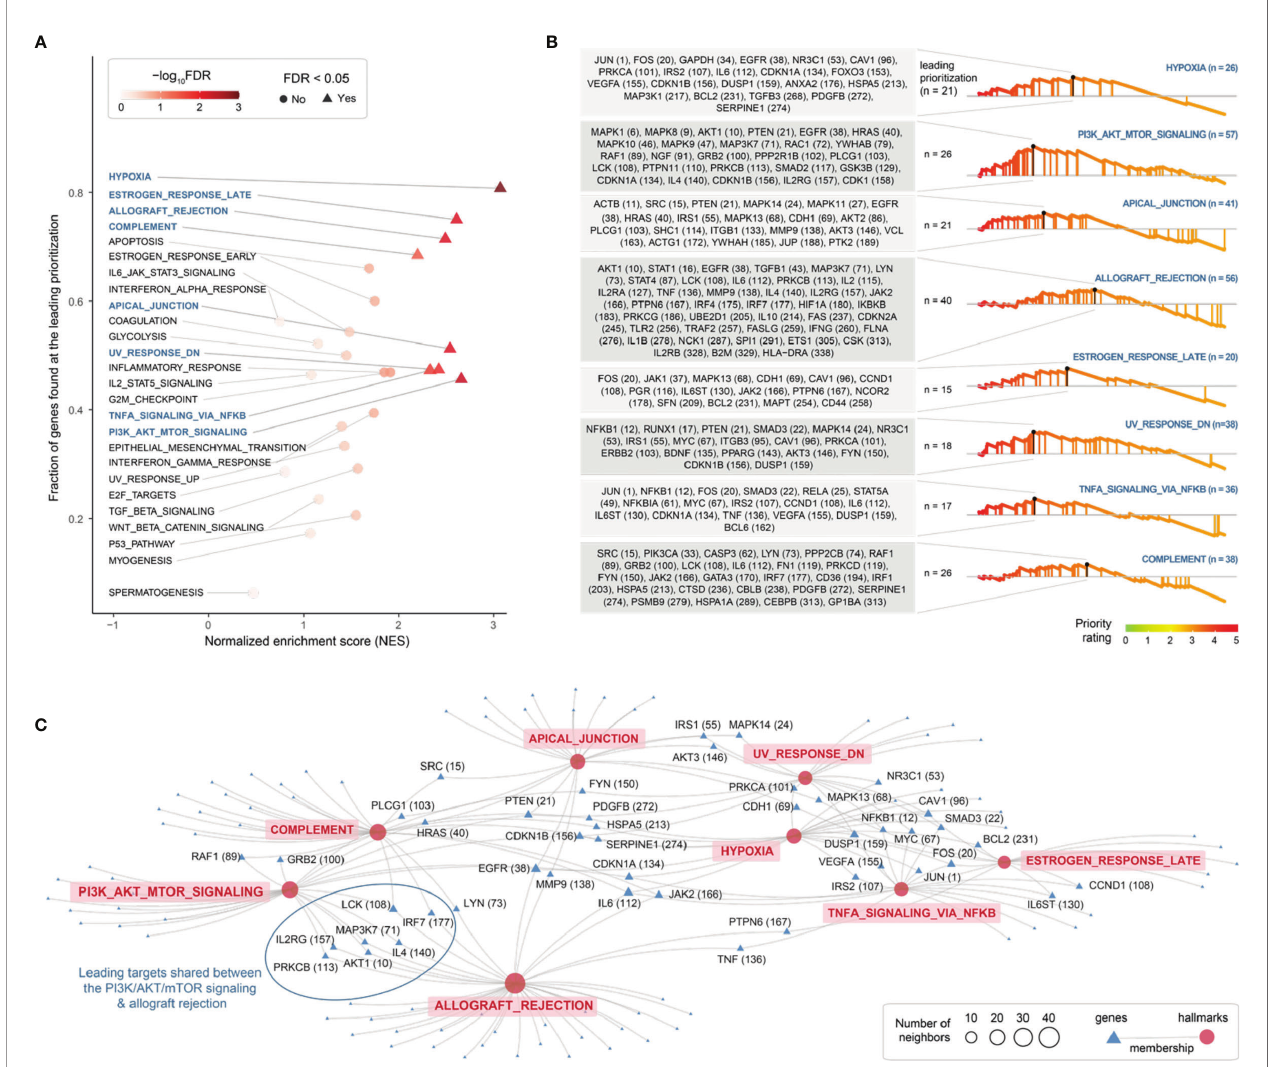
FIGURE 5 | Exploring molecular hallmarks of therapeutic targeting in endometriosis. (A) Scatter plot of molecular hallmark enrichments, including normalized enrichment score (NES; x-axis), fraction of hallmark genes found at the leading prioritization (y-axis), and the enrichment signi fi cance (FDR) calculated using target set enrichment analysis. Enriched hallmarks (FDR < 0.05) are shaped in triangle and labelled in blue. (B) Details on enriched hallmarks. Left : the gene list found at the leading prioritization, with the number in the parentheses indicating priority rank. Right : the leading prioritization (visually de fi ned as the left-most region ahead of the peak). (C) Network-like representation of enriched hallmarks and member genes. Inter-hallmark sharing genes are also labelled including priority rank. For example, genes shared between two hallmarks (the PI3K/AKT/mTOR signalling and allograft rejection) are framed in oval